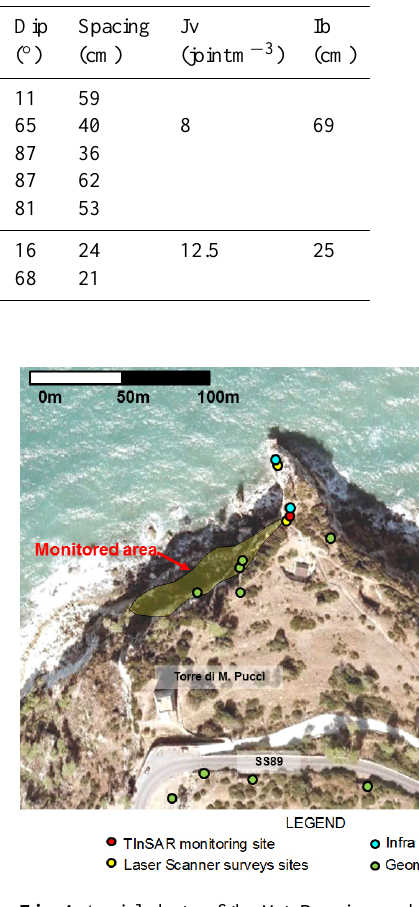
Fig. 4. Aerial photo of the Mt. Pucci area showing the investigated sector (Mt. Pucci Cliff); the locations of the GBInSAR, TLS, and IRT remote surveys; and the geomechanical